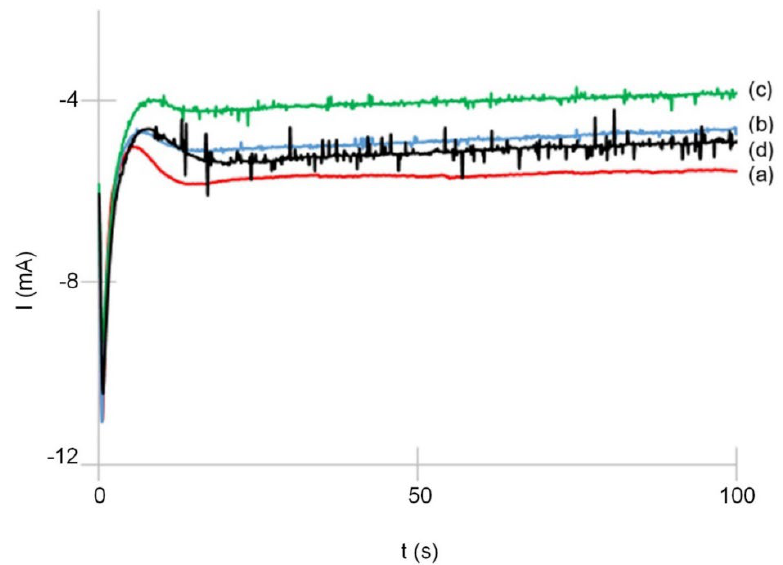
Figure 2. Potentiostatic current transients for the deposition of CaP coatings at − 1.55 V/ AgAgCl under ( a ) B = 0 T, ( b ) B = 6 T ┴ J, ( c ) B = 12 T ┴ J, and ( d ) 16 T ┴ J, during the first 50 s.